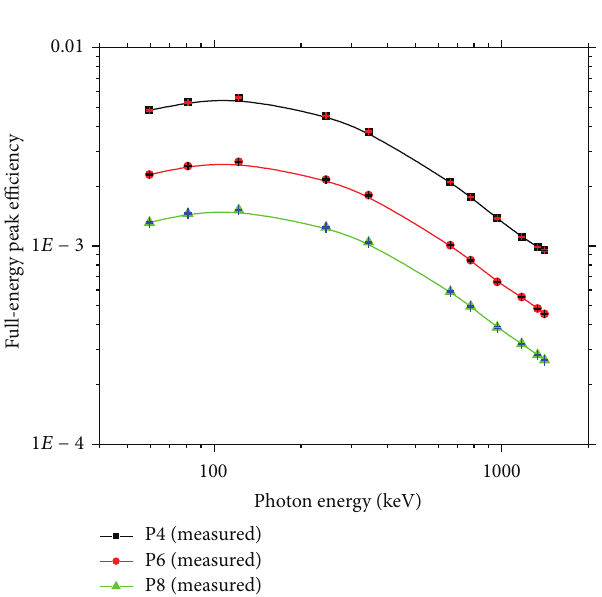
Figure 4: Reference experimental calibration curve for point sources measured at three different axial distances, P4, P6, and P8, from the NaI(Tl) detector